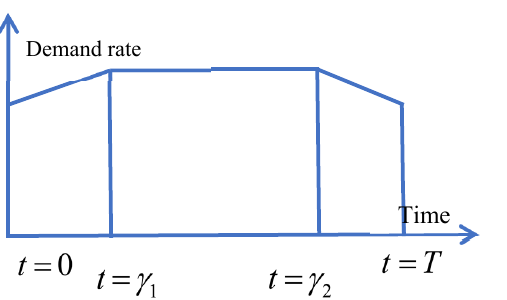
Figure 1. Pictorial representation of trapezoidal demand pattern function of the demand